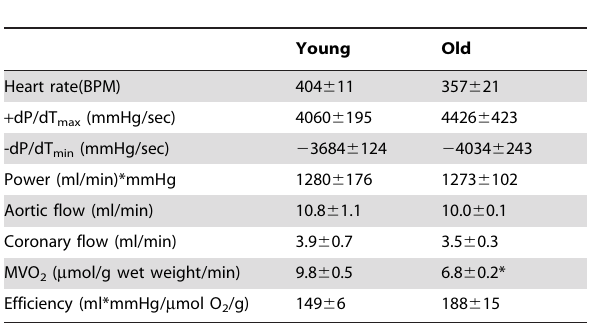
Table 3. Functional measurement during isolated working heart with 13 C-labeled substrates at standard afterload (50 mmHg).